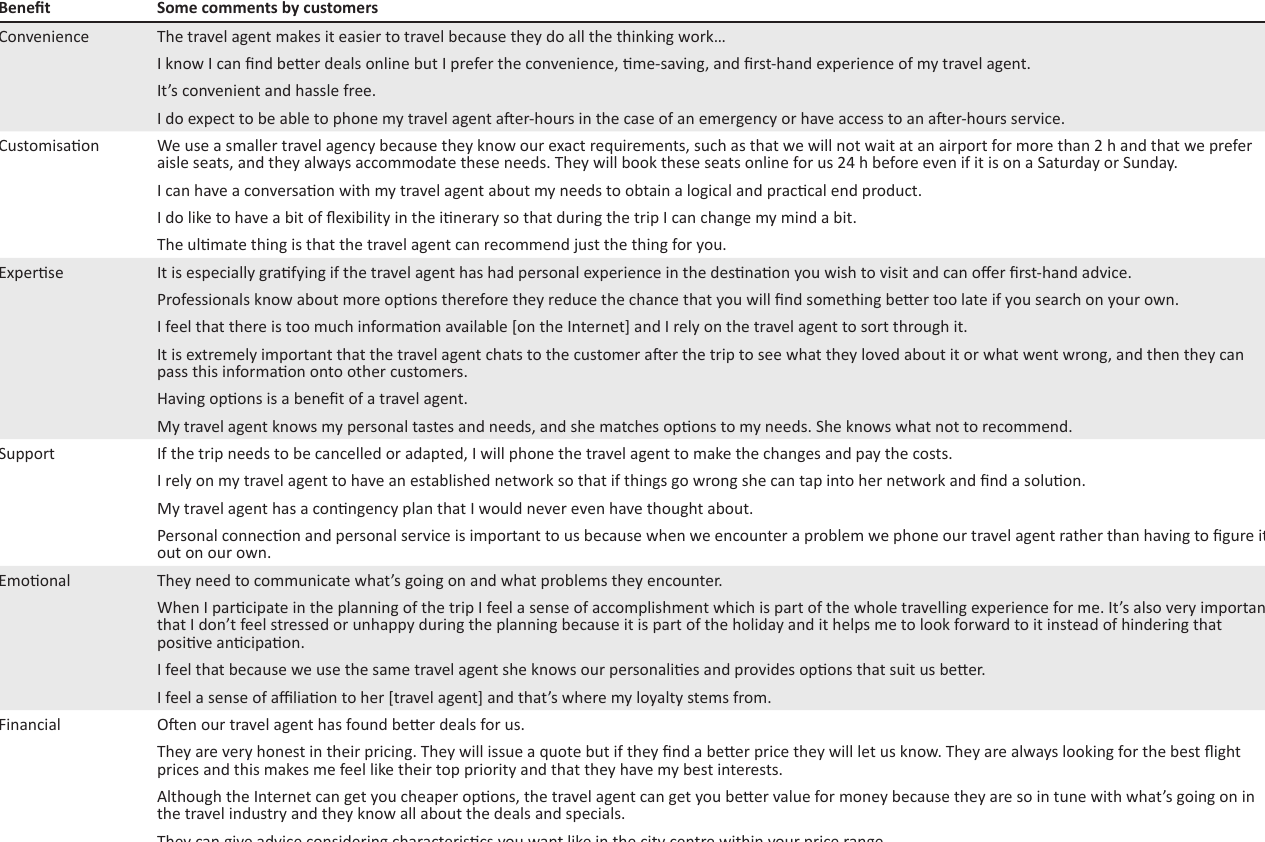
TABLE 1-A1: Customers’ perceived benefits of using a travel